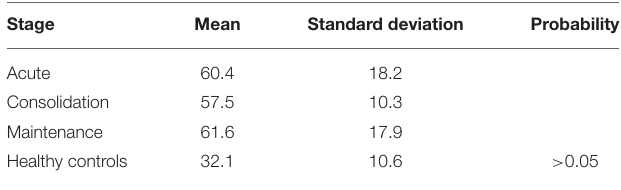
TABLE 1 | Standard deviation of